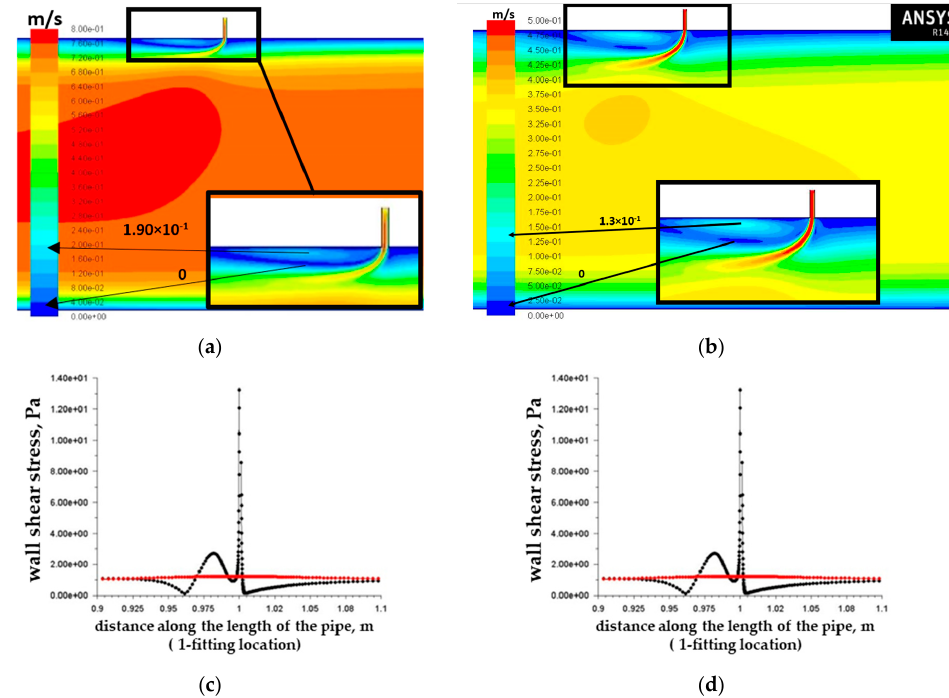
Figure 4. Velocity modulus field in the vertical section of the pipe for the variant of the nozzle-type ICD channel inclination angle of 90° and fluid velocity at the pipe inlet of 0.662 m/s ( a ) and 0.297 m/s ( b ); graphs of shear stresses on the pipe walls at 0.1 m from the nozzle of fluid velocity at the pipe inlet of 0.662 m/s ( c ) and 0.297 m/s ( d ). The black lines correspond to the wall on which the nozzle-type ICD is located, and the red lines correspond to the opposite wall.